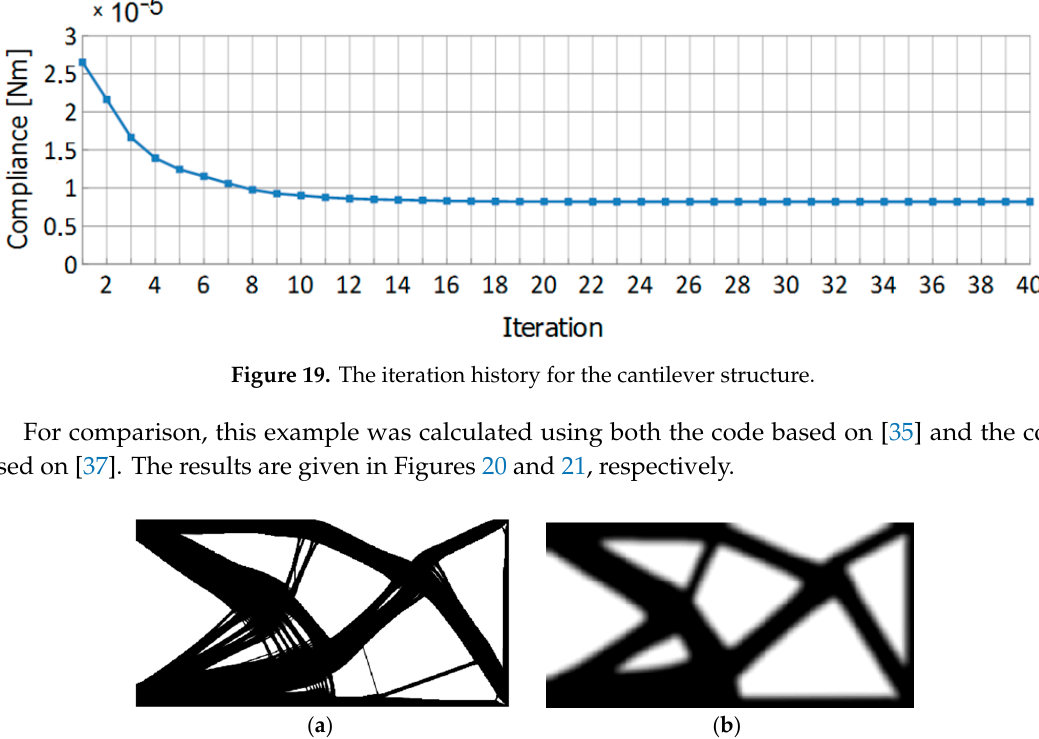
Figure 20. The final topology obtained using [35] with a small ( a ) and a large ( b ) filtering radius.